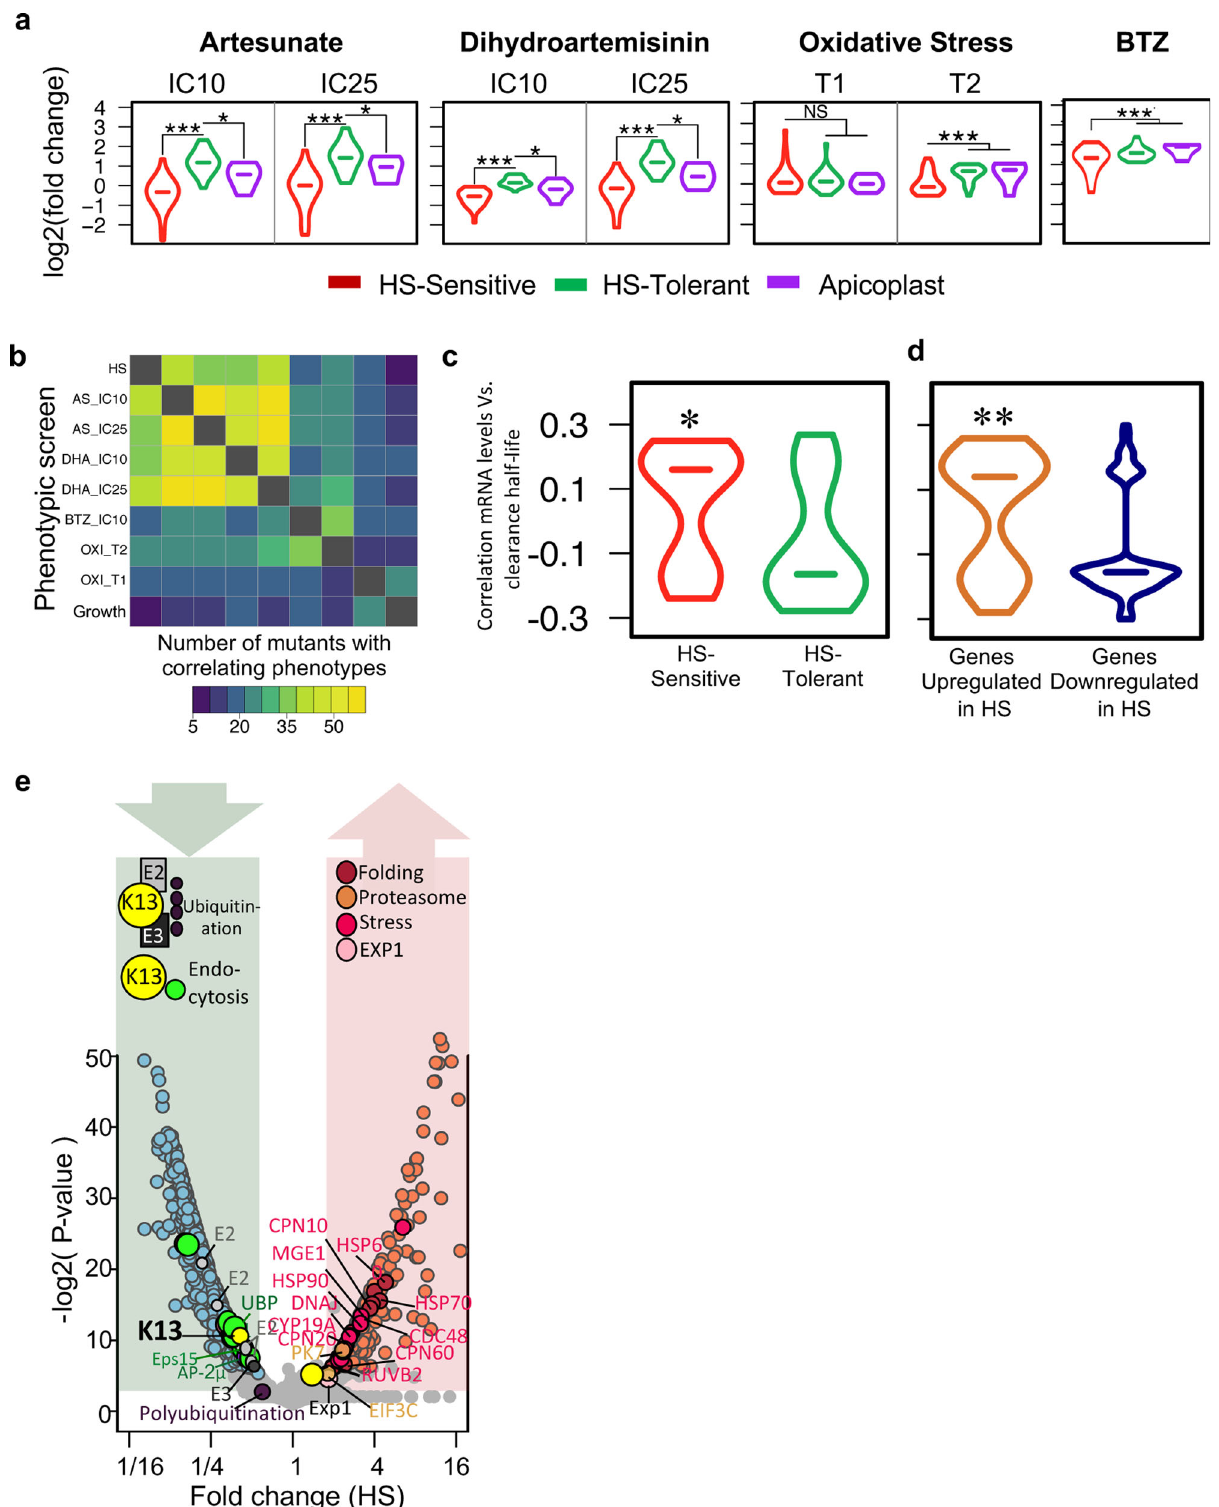
induced damage. Artemisinins mount a multi-pronged attack against the parasite by causing a global, non-speci fi c accumula- tion of damaged parasite proteins, which are then polyubiquiti- nated/marked for degradation, while also inhibiting proteasome- function. These polyubiquitinated proteins ultimately overwhelm the parasite ’ s decreased capacity for UPS-mediated protein degradation 13 . Key ubiquitinating components of this system,